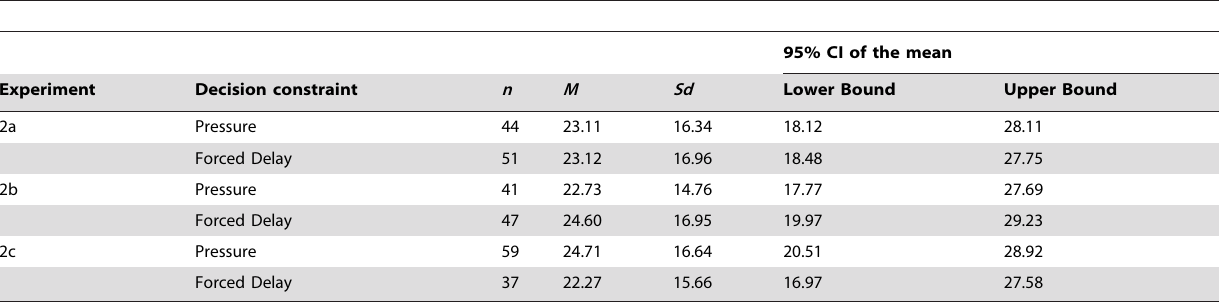
Table 4. Number of Participants ( n ), Mean (M), Standard Deviation ( Sd ) of Participants’ Contributions (in dollar cents) and the 95% Confidence Interval (CI) per Decision Constraint Condition for Experiments 2a, 2b and 2c.